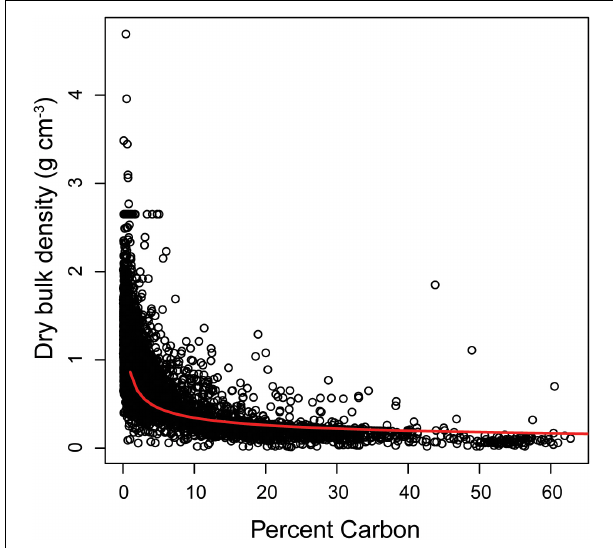
FIGURE 2 | Pedotransfer function to estimate dry bulk density based on carbon content ( R 2 = 0.65, n = 6,172). Dry bulk density = 0.861 *%C − 0 . 399 .